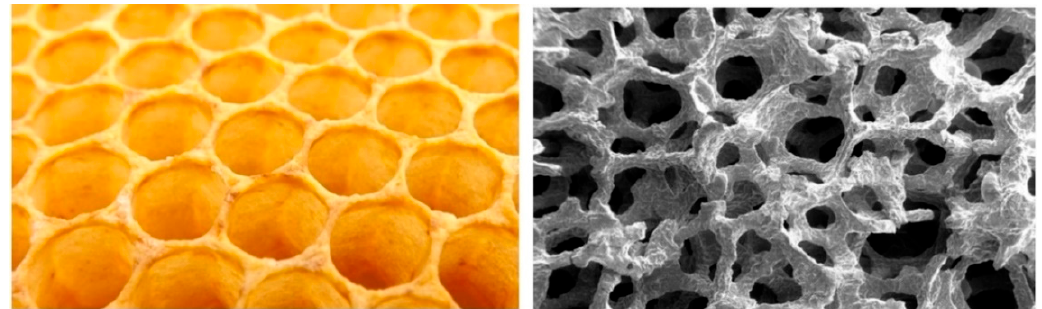
Figure 7. The bee’s honeycomb ( left ) is an example of a prismatic cellular material. The stochastic metal foam ( right ) is an example of a 3D cellular material (Attr: SecretDisc, Wikimedia Commons).